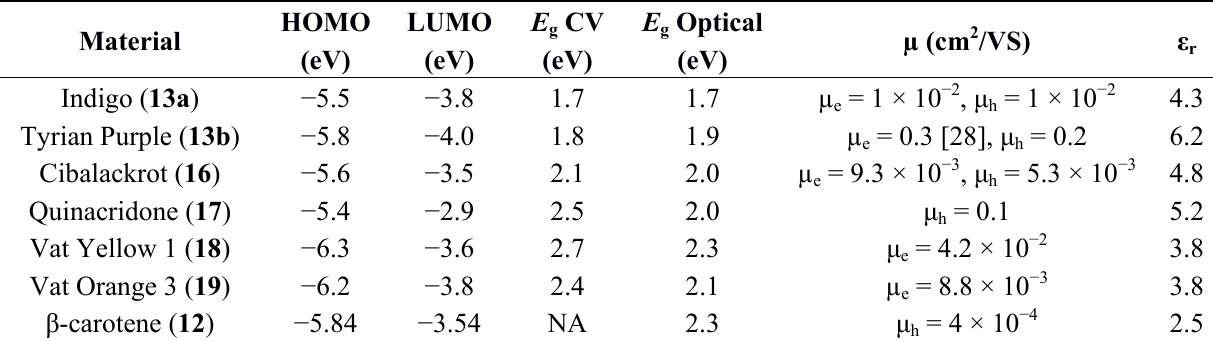
Table 1. Overview of electrical properties of natural semiconductors comprising the energy levels (HOMO, LUMO), the band gab E or by optical measurements, the charge carrier mobility for holes (µ well as the dielectric constant ε